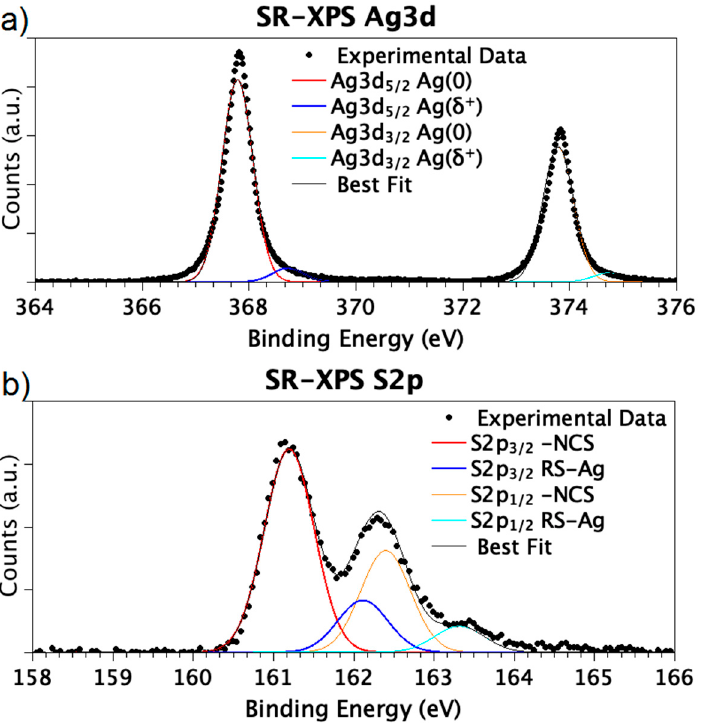
Figure 5. ( a ) Ag3d SR-XPS spectrum and ( b ) S2p spectrum collected on AgNPs–FITC. Data for AgNPs–RITC are analogous (Table S2 in Supplementary Materials).